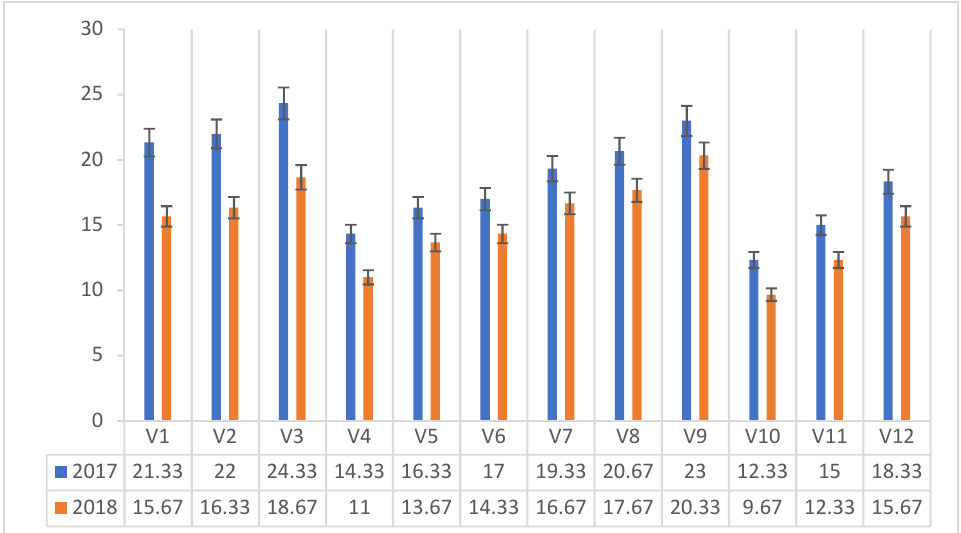
Figure 2. Vitamin C content of Agaricus blazei Murrill mushrooms (mg 100g −1 dm) in two years of experiments.